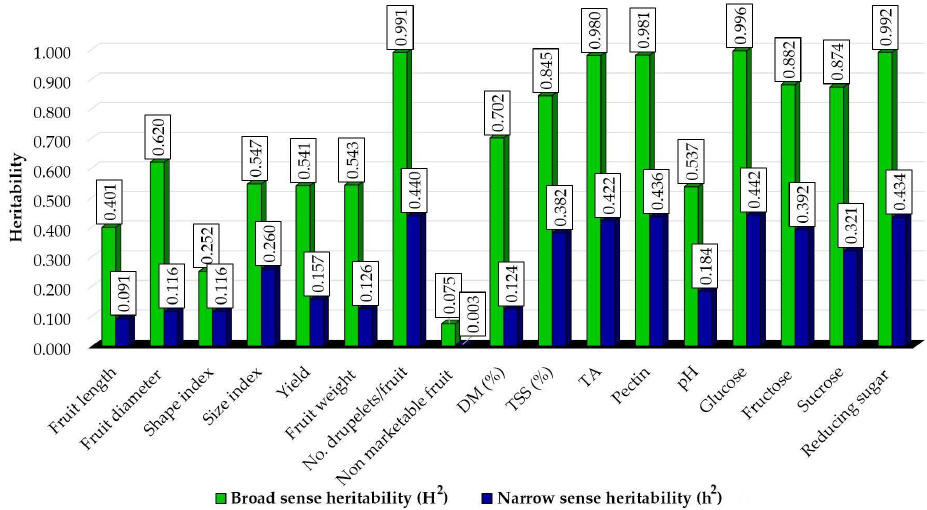
Figure 13. Broad-sense heritability (H 2 ) and narrow-sense heritability (h 2 ) of the 17 traits analyzed in the experiment with the selections belonging to the common parent represented by the Tulameen cultivar (used as mother— ♀ or father— ♂ genitor [(3 ♀ × Autumn Bliss) + (Glen Moy × 3 ♂ ) + (2 ♀ × Pathfinder) + (2 ♀ × Opal)] in half-sibling families). DM represents dry matter, TSS represents total soluble solids, and TA represents titratable acidity.